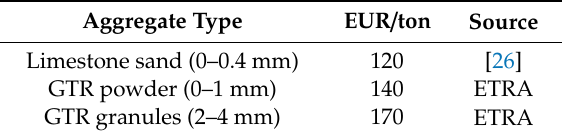
Table 4. Average cost (per ton.) of aggregates used in the production of cement mixtures .